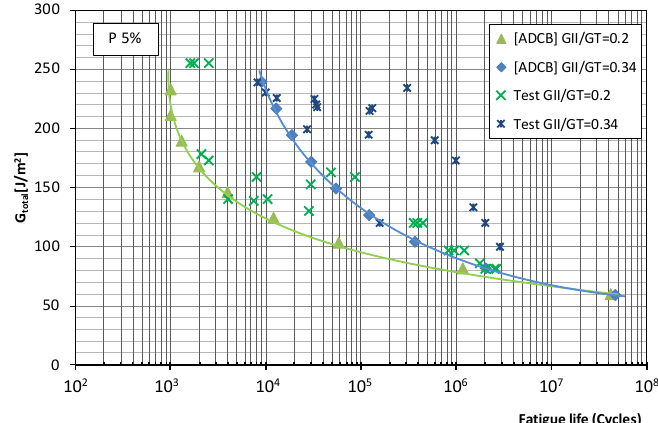
Figure 5. Material fatigue curves, ADCB test, for a 5% probability of fracture and two mode mixity ratios: 0.2 and 0.34.